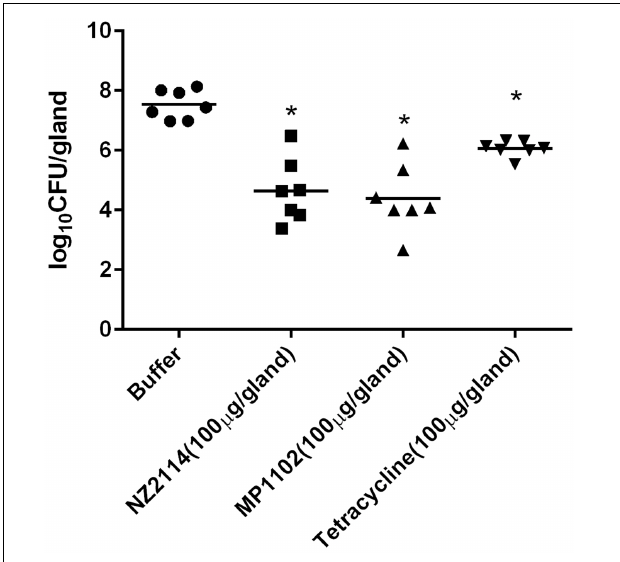
FIGURE 5 | Quantification of bacterial numbers in the mammary glands in untreated S. aureus -infected mice (circles) and infected mice treated with NZ2114 (squares), MP1102 (triangles), or tetracycline (inverted triangles), after 24 h. An asterisk ( ∗ ) demonstrates a significant difference ( P < 0.05) in comparison with the buffer group.